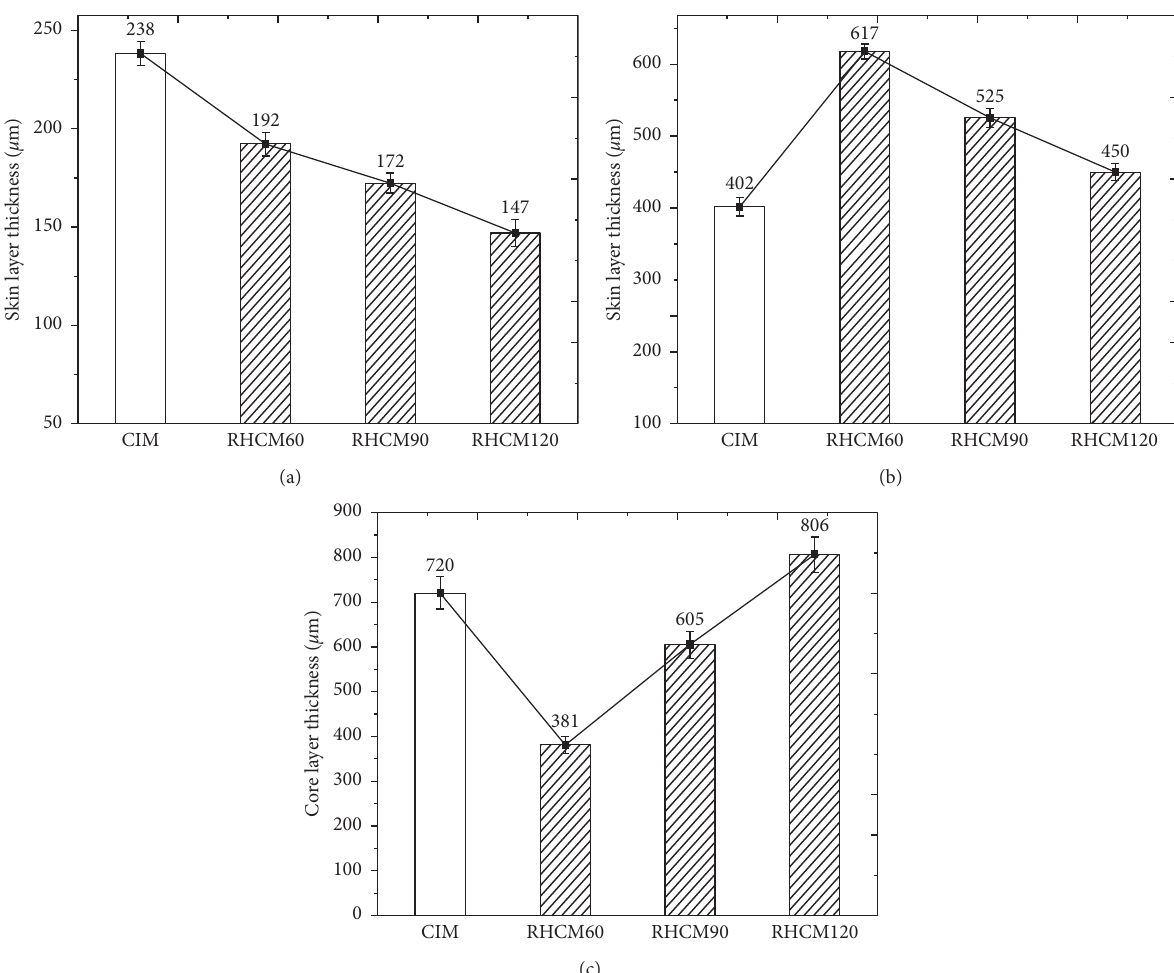
Figure 5: Schematic of each layer thickness change trend in RHCM and CIM samples: (a) skin layer thickness; (b) shear layer thickness; (c) core layer thickness.